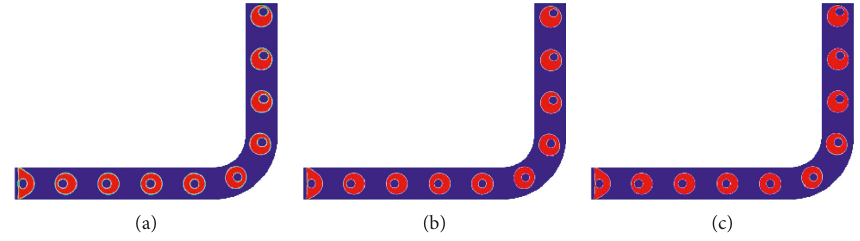
Figure 2: Grid independence test of different cell numbers n